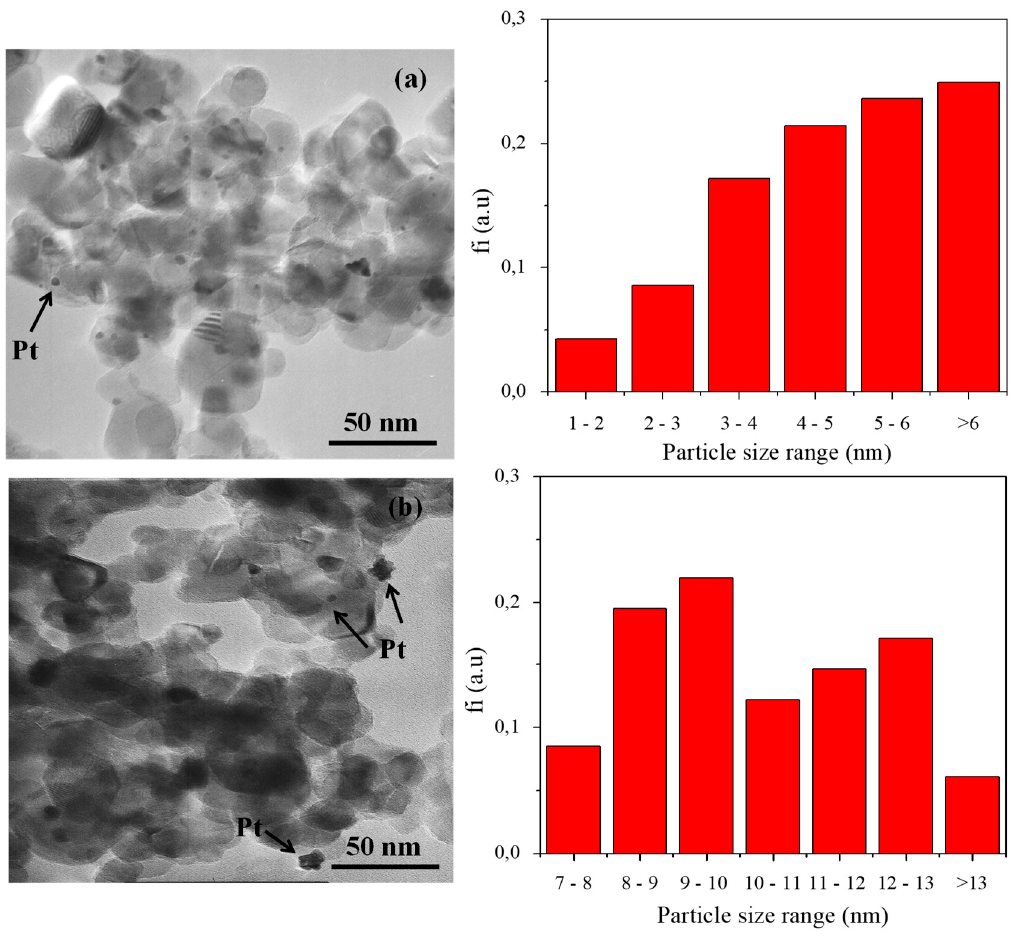
Figure 3. TEM images for analyzed samples. ( a ) Pt–F–TiO 2 and ( b ) Pt–F–P25.